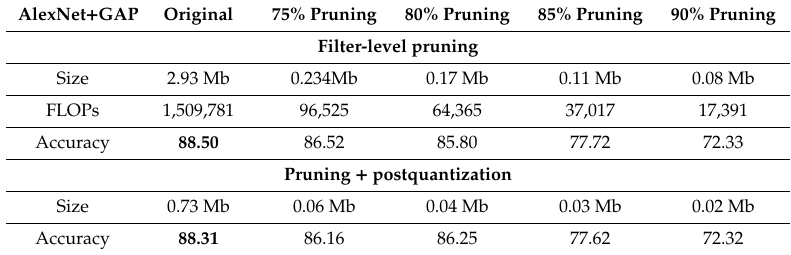
Table 10. Comparison in terms of size and Flops of filter-level pruning on AlexNet + GAP with the plant seedlings dataset.